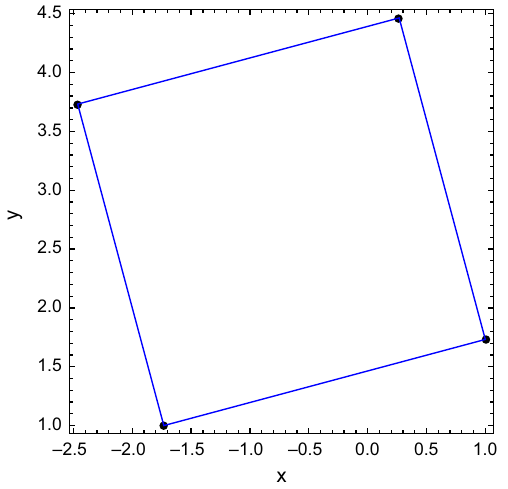
Fig. 11 Newton polytope for Eq. (92) Fig. 12 Newton polytope after transformations Eq. (93)